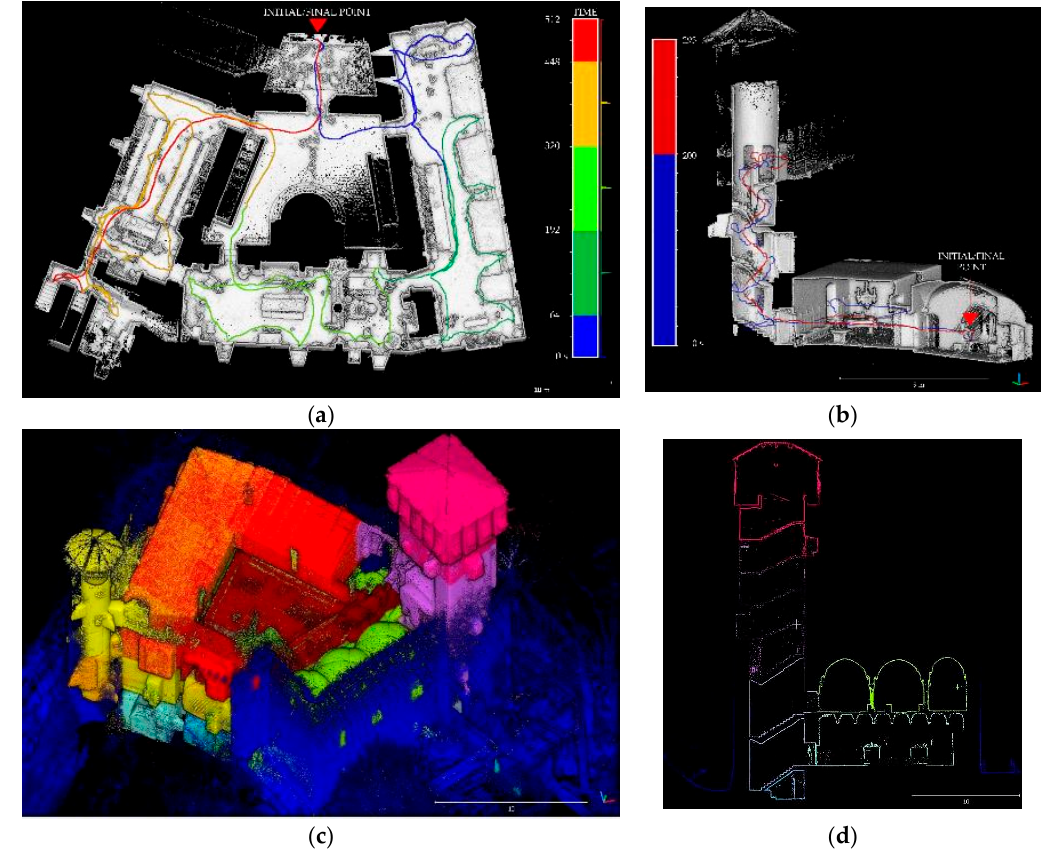
Figure 8. Example of SLAM-trajectory in the Rocca colourized by time: ( a ) Close loop with some roundtrip parts; ( b ) Roundtrip on the tower: going (blue) and return (red). ( c ) All of the reprocessed ZEB point clouds after the merge process, each colour corresponds to one scan, in blue the external one and ( d ) vertical section of the point cloud.